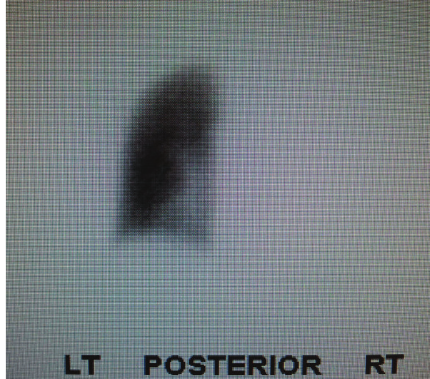
Figure 2: Albumin perfusion scan revealing absence of right lung perfusion.